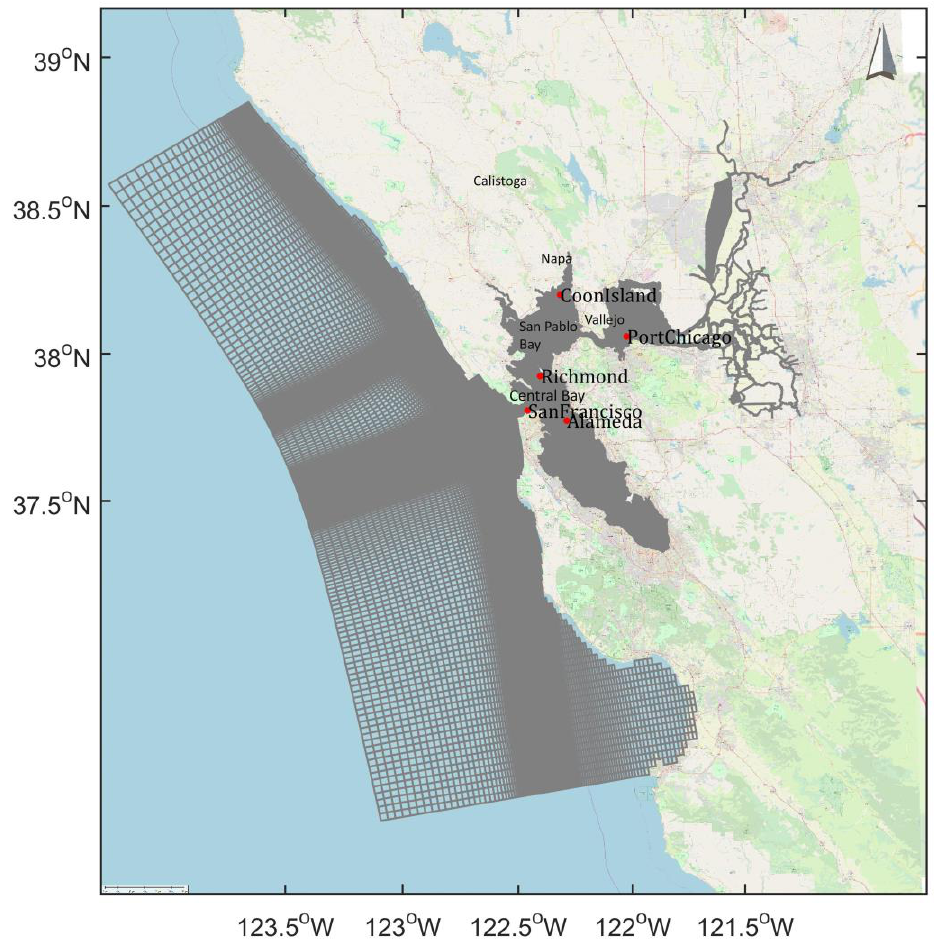
Figure 1. Map of San Francisco Bay, including the Napa River watershed and model grid. Gray mesh is grid. Red dots indicate locations with water level records. Map is from openstreetmap.org.